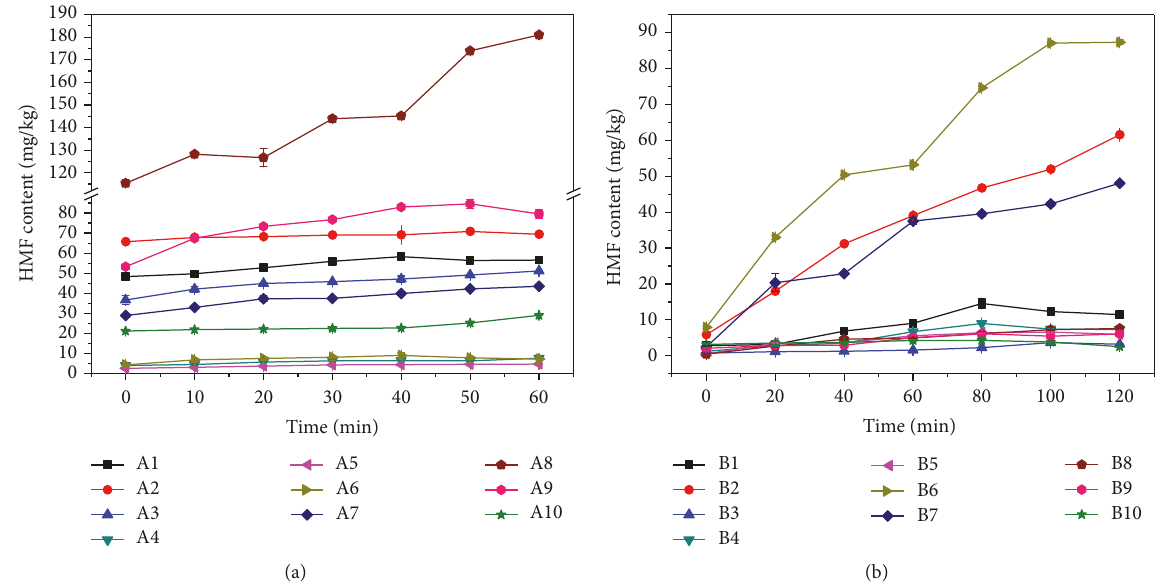
Figure 3: HMF contents of thermal process models (vinegar samples (a), soy sauce samples (b)) at different heating time.